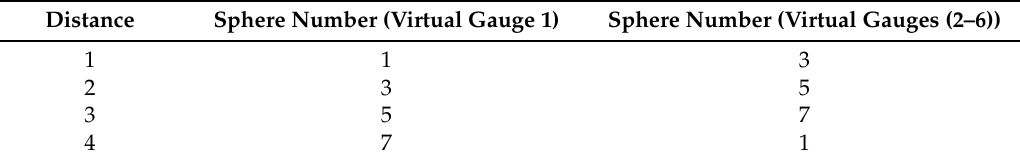
Table 4. Evaluation method 3: crossed virtual distances definition.